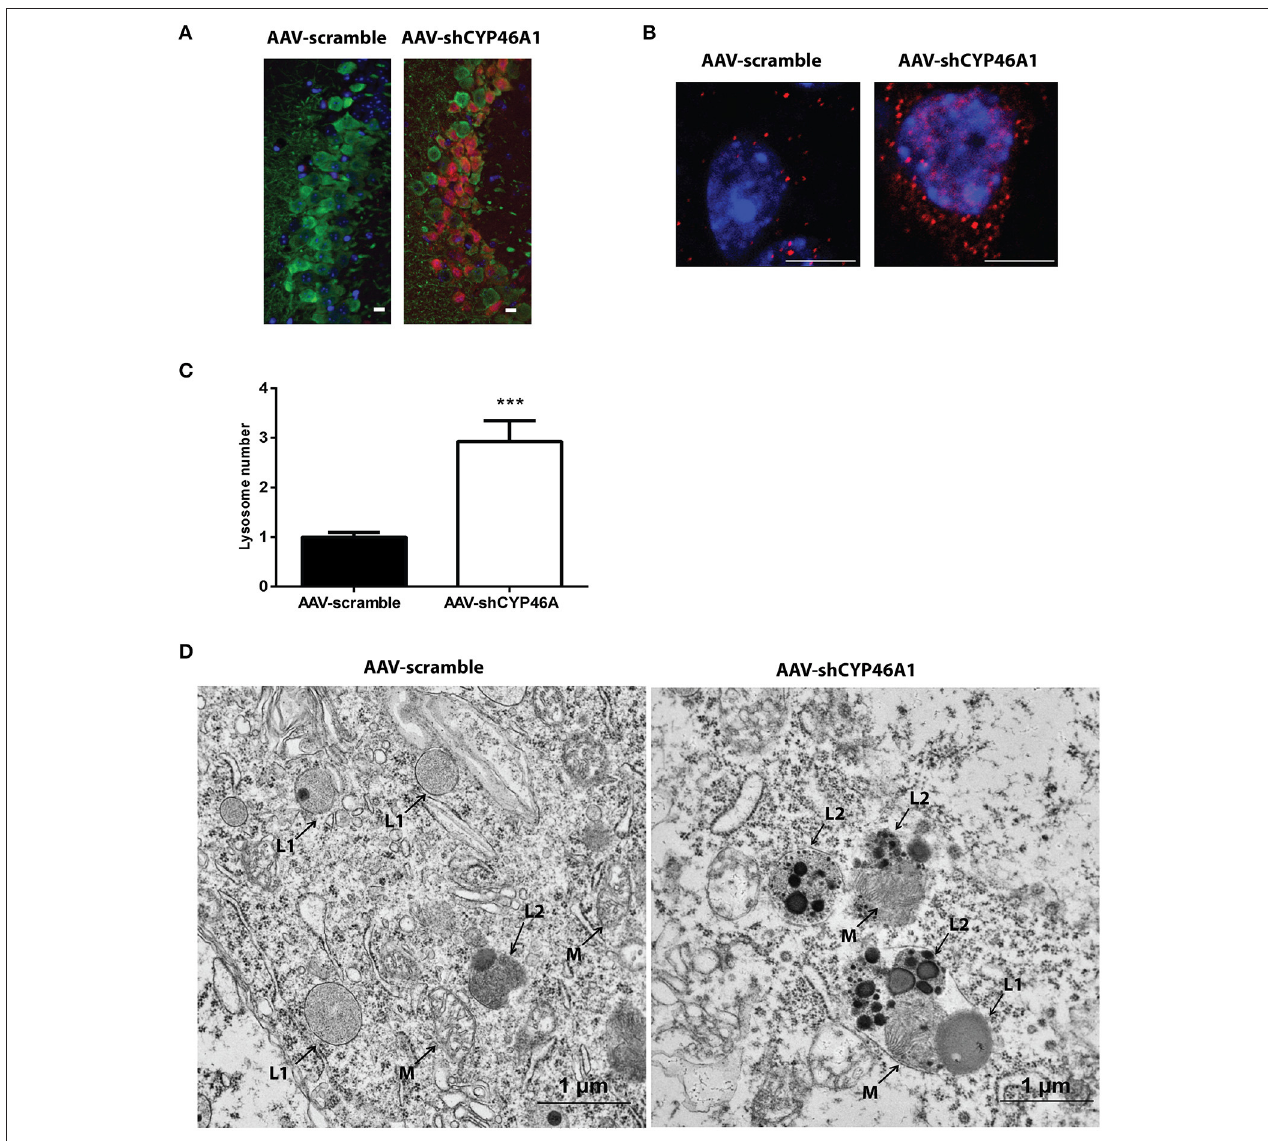
FIGURE 7 | Accumulation and ultrastructural modifications of lysosomes in CA3a neurons of AAV-shCYP46A1 injected mice. (A) Representative eGFP immunostaining (green) and LAMP-1 immunoreactivity (lysosomal cell, red) (scale bar: 50 µ m) (B) Representative image by laser confocal microscopy showing increased puncta-like immunoreactivity of LAMP-1 (red) in CA3a neurons of the hippocampus of C57BL/6 mice 4 weeks after injection of AAV-shCYP46A1 vector compared to AAV-scramble. Nuclei are counterstained with DAPI (blue) (scale bar: 6 µ m). (C) Quantification of the number of LAMP-1-positive lysosomes in CA3a pyramidal cells at 4 weeks after AAV5-shCYP injection normalized to values from AAV5-scramble injected mice (30 cells of 5 mice per vector per time; 2-tailed unpaired t -test was performed. *** P < 0.0001. (D) Electron micrographs showing abnormal lysosomes in CA3a neurons of C57BL/6 mice 4 weeks after injection of AAV-shCYP46A1 vector (scale bar: 1 µ m). (M): mitochondria, (L1): primary lysosomes, (L2): secondary